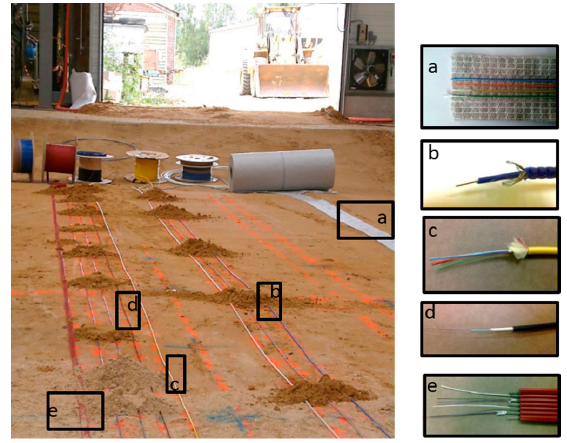
Figure 4. (Left) Picture of a one-to-one scale mock-up of dyke where several strain sensing cables (whose zooms are provided on the right) were tested.